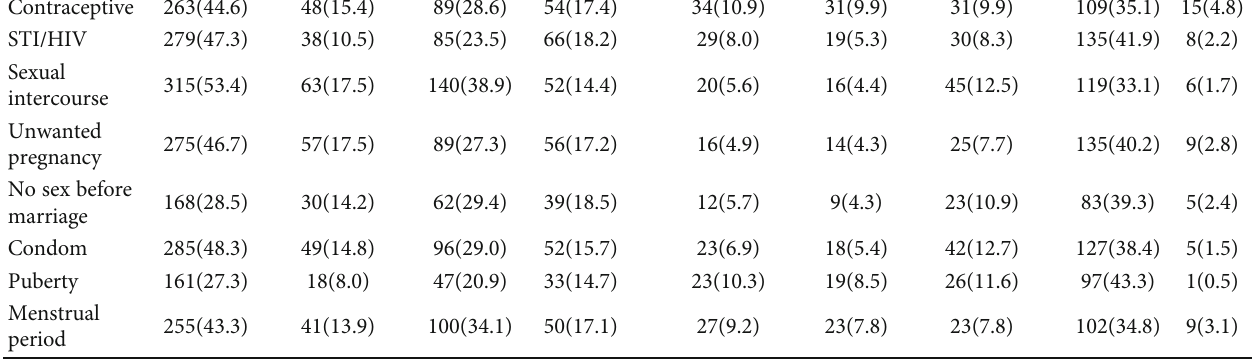
∗ Multiple responses and percentage in parenthesis.